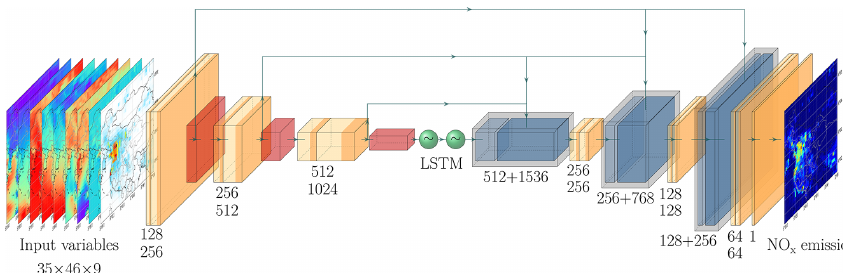
Figure 2. Schematic representation of the U-net model for the prediction of Chinese NO x emissions. The CNN layers with 3 × 3 filters are shown in orange. The dark orange regions indicate the application of softplus activation functions. The 2 × 2 max-pooling layers are shown in red. The two green circles represent the LSTM cells. The 2 × 2 up-convolutional layers are shown in light blue, which are concatenated (indicated as grey boxes) with the transferred latent vectors (shown as dark blue boxes) from the encoder. The arrows indicate the residual connections. Table 1. Input variables for NO x emission inversion using the DL